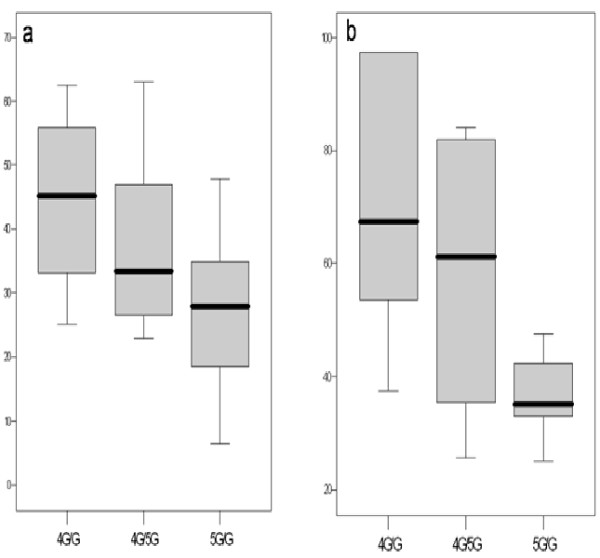
PAI-1 levels according to PAI-1genotypes. A. Preoperative. B. ICU admission (0-hr).